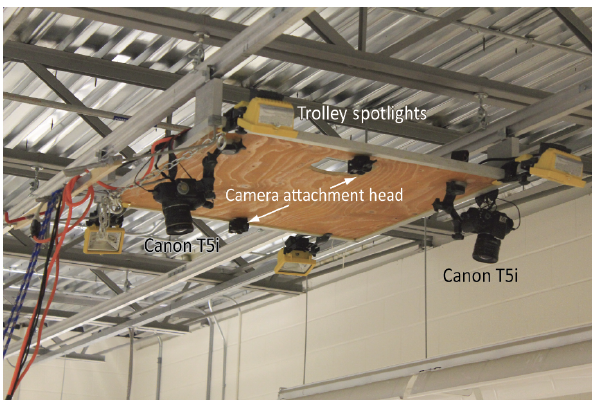
Figure 2. Movable trolley above model surface with two Canon cameras in a convergent position as well as four